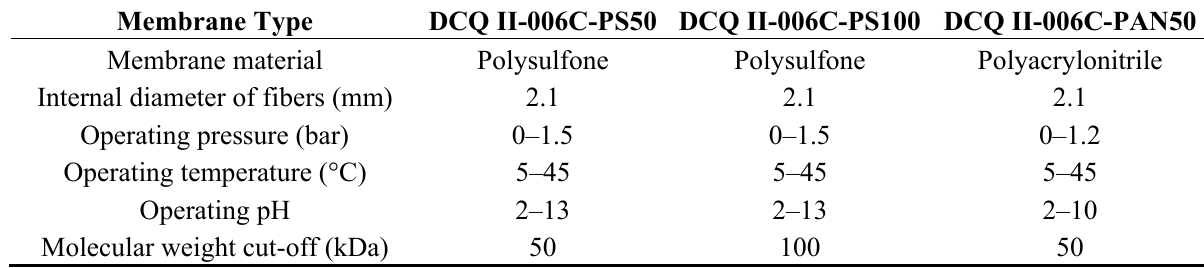
Table 1. Characteristics of hollow fiber ultrafiltration (UF) membrane